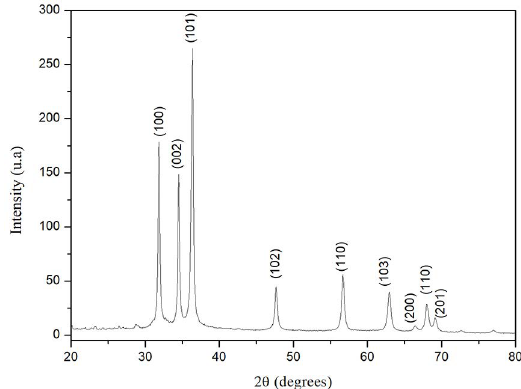
Figure 2. X-ray diffractogram of ZnO particles synthesized by coprecipitation. The samples were investigated by XRD and the synthesized particles showed peaks identified as (100), (002), (101), (102), (110), (103), (200), (110) and (201), which correspond to the reflection planes characteristic of ZnO of hexagonal wurtzite crystalline phase. All peaks were identified characteristic to ZnO, with no peaks corresponding to other compounds or impurities 10 . Thus, the synthesized zinc oxide showed high purity and the peaks were narrow and intense indicating a high crystallinity of the oxide. The cataloging of the peaks was performed by comparison with the crystallographic record PDF 01-075-0576 using